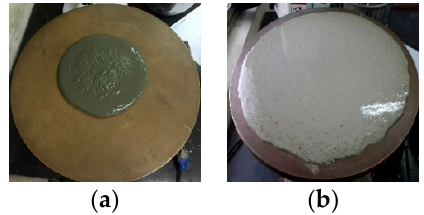
Figure 4. Relationship between the viscosity and the spindle speed of matrixes: ( a ) W / B = 0.28; ( b ) W / B = 0.31; ( c ) W / B = 0.34; ( d ) W / B = 0.37.